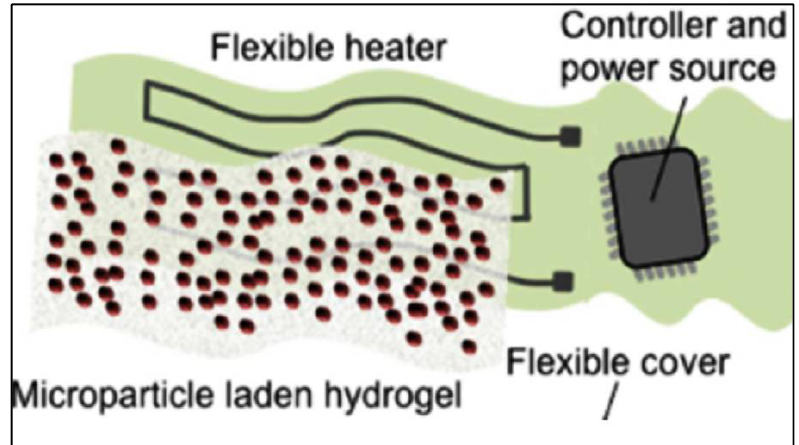
Figure 3. Schematic of the smart wound dressing depicting the major elements. Reprinted by permission from John Wiley and Sons: Advanced Healthcare Materials reference [78] Copyright 2016.